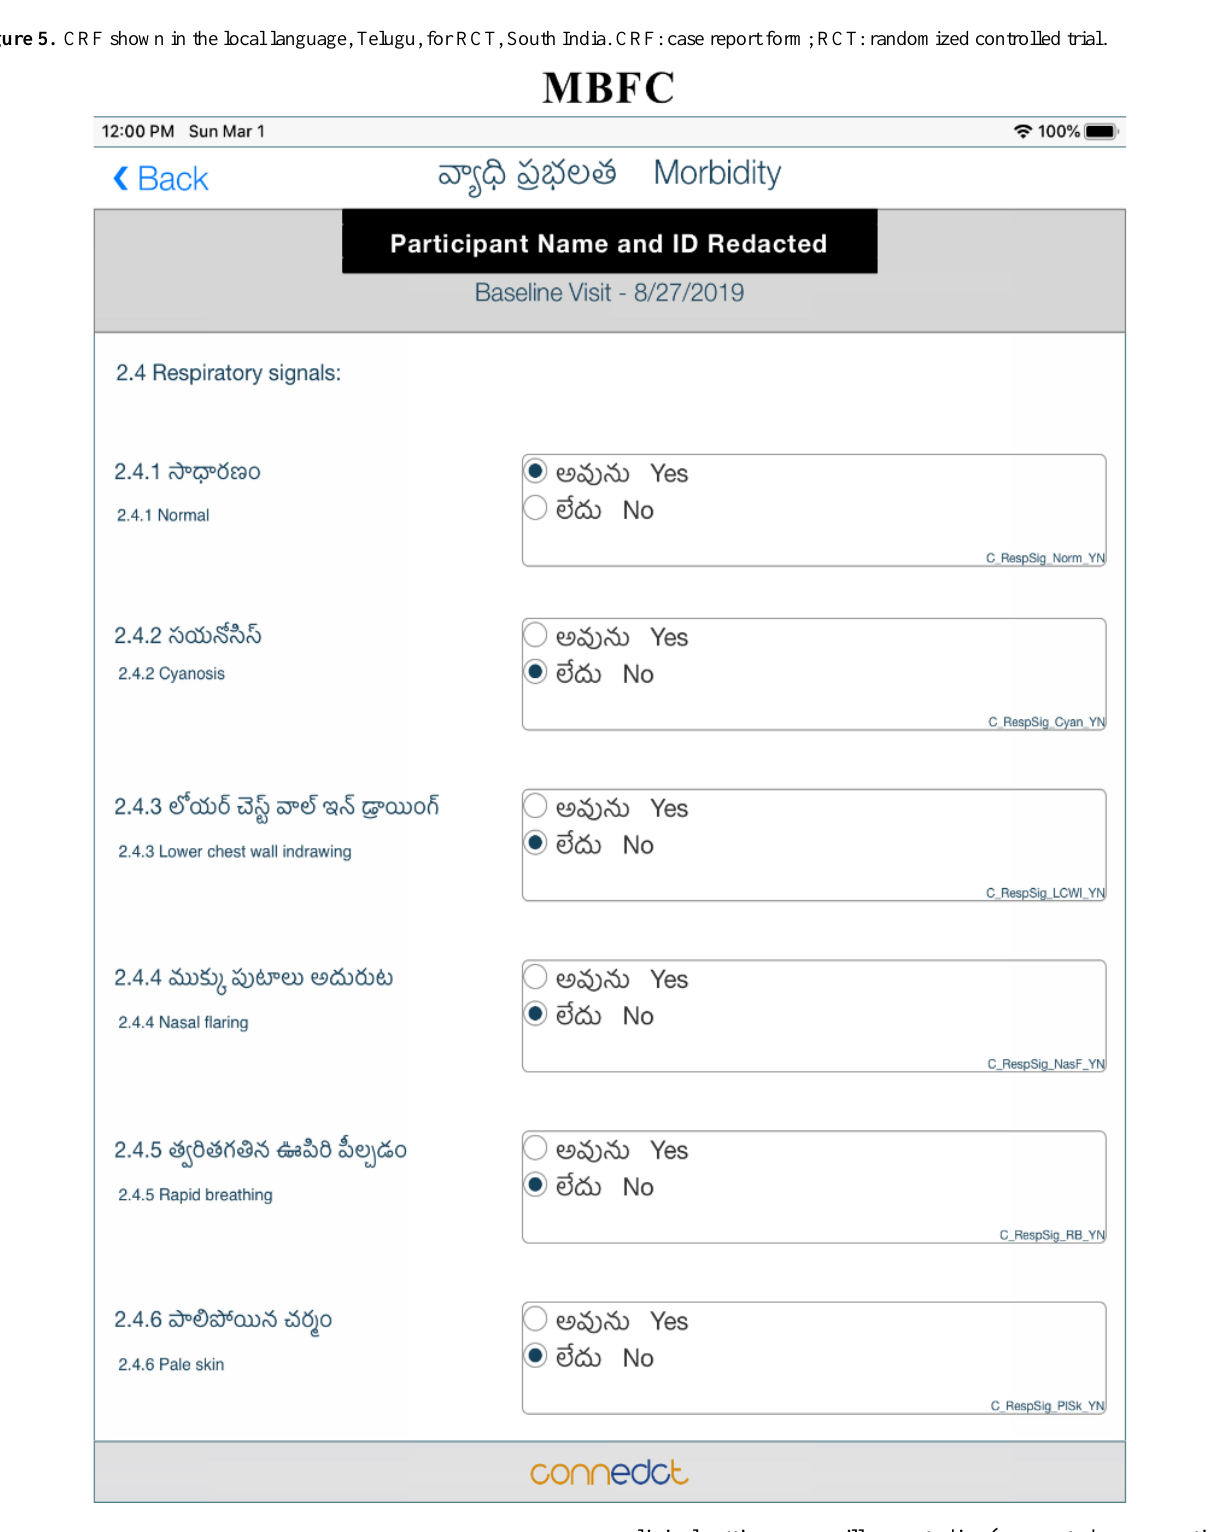
Figure 5. CRF shown in the local language, Telugu, for RCT, South India. CRF: case report form; RCT: randomized controlled